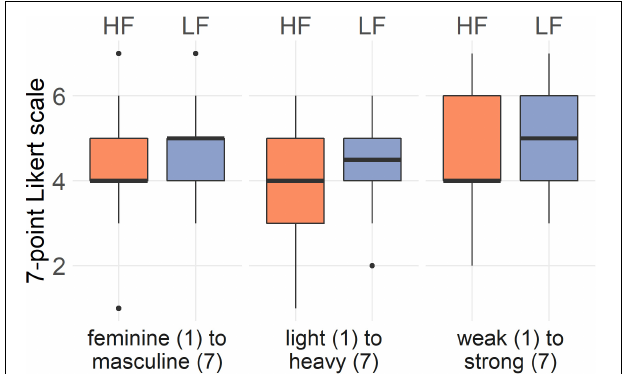
FIGURE 5 | Answers of the men to the bodily feelings questions on perceived masculinity and femininity, body weight, and strength in the high frequency and low frequency condition. Black horizontal line shows median score; lower and upper hinge correspond to the first and third quartiles (25th and 75th